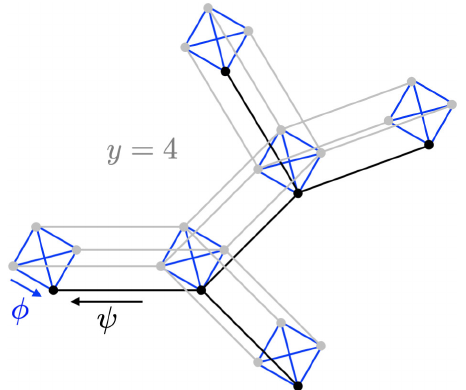
FIG. 14. A schematic view of the replicated graph for y ¼ 4 . The black graph is the original one, while the gray graphs are the y − 1 replicas. Blue ferromagnetic couplings are present among every pair of replicated vertices with the same site index. Replicated BP uses two kinds of messages, ψ and ϕ , represented by black and blue